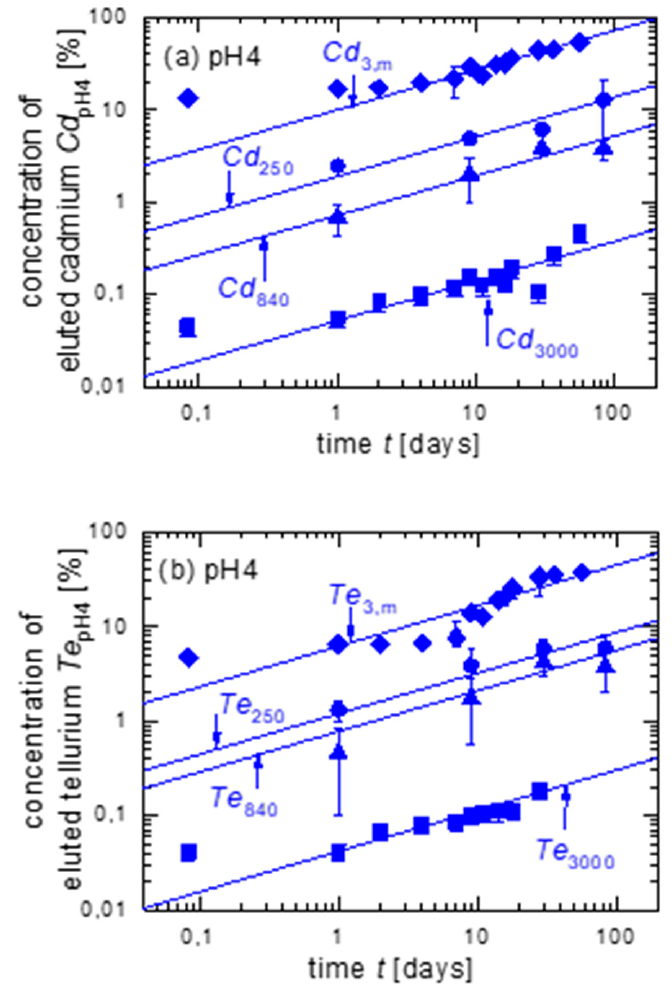
Figure 3. Elution of Cd pH4 and Te pH4 in solutions with pH4 out of three different CdTe powders in comparison to the elution from milled module pieces Cd 3,m and Te 3,m [6] (uppermost curves). Lines in both figures represent simulations after Equation (2), with Cd pH4 ~ t n with the diffusional exponent n = 0.43. ( a ) Cd 3000 released from powder with d 3000 ≤ 3000 µ m shows the weakest elution; the values Cd 250 for powder with d 250 ≤ 250 µ m are about a factor of 40 higher. Even higher are the Cd 3,m -values of the milled module pieces: They almost exceed more than 50% after 56 days. It holds Cd 3000 < Cd 840 < Cd 250 < Cd 3,m . ( b ) Leaching of Te resembles that of Cd: It holds Te 3000 < Te 840 < Te 250 < Te 3,m . Figure 4a,b present our data for the elution of CdTe powder in aqueous solutions with pH7. Clearly, the total values for the elution of Cd as well as of Te are lower than those in pH4 (compare Fissure 3a,b). Nevertheless, we find the same time dependence for both Cd and Te; their eluted amount increases with t 0 . 43 . The elution out of Cd 840 and Cd 3000 show small narrow differences. We observe Cd 3000 ≈ Cd 840 < Cd 250 as well as Te 3000 ≈ Te 840 < Te 250 . Unfortunately, no elution values of milled CdTe modules exist for